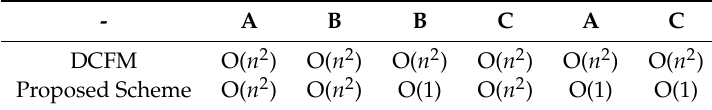
Table 4. Comparison of Computational Complexities for a